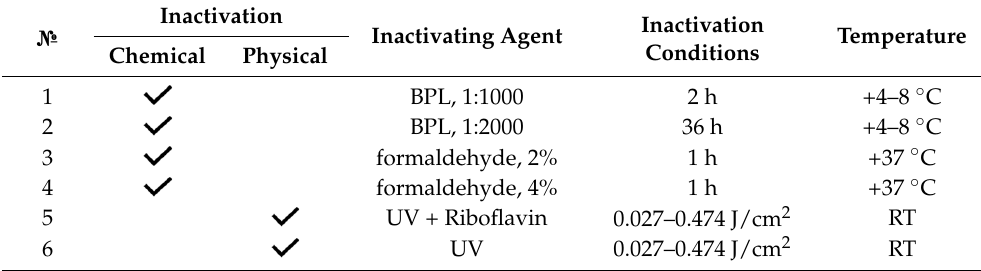
Table 1. Variants of virus inactivation.